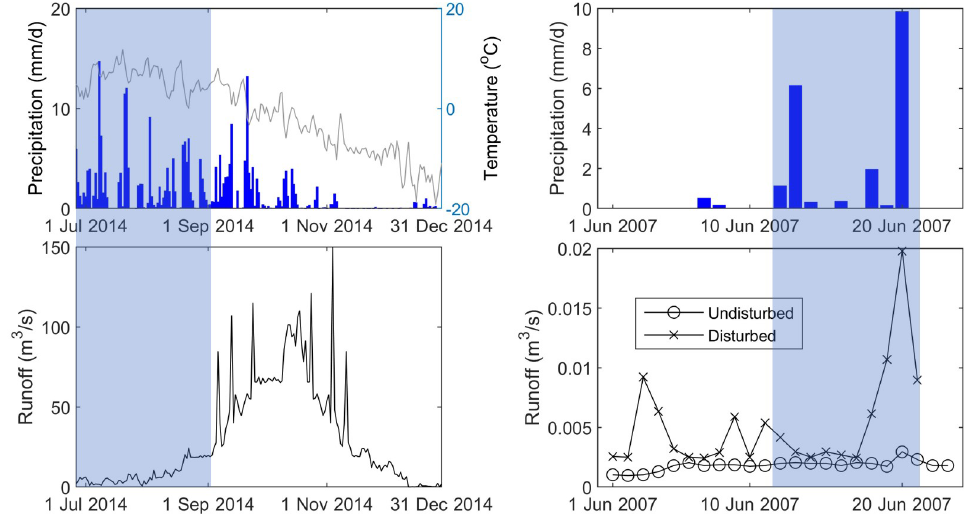
Figure 4. The little runoff in the early thawing season (LRET) phenomenon in other places, e.g., the headwater of Yellow River (Yang et al., 2019) and a small headwater catchment at the Cape Bounty Arctic Watershed Observatory, Melville Island, Nunavut, Canada (Lafrenière and Lamoureux, 2019).